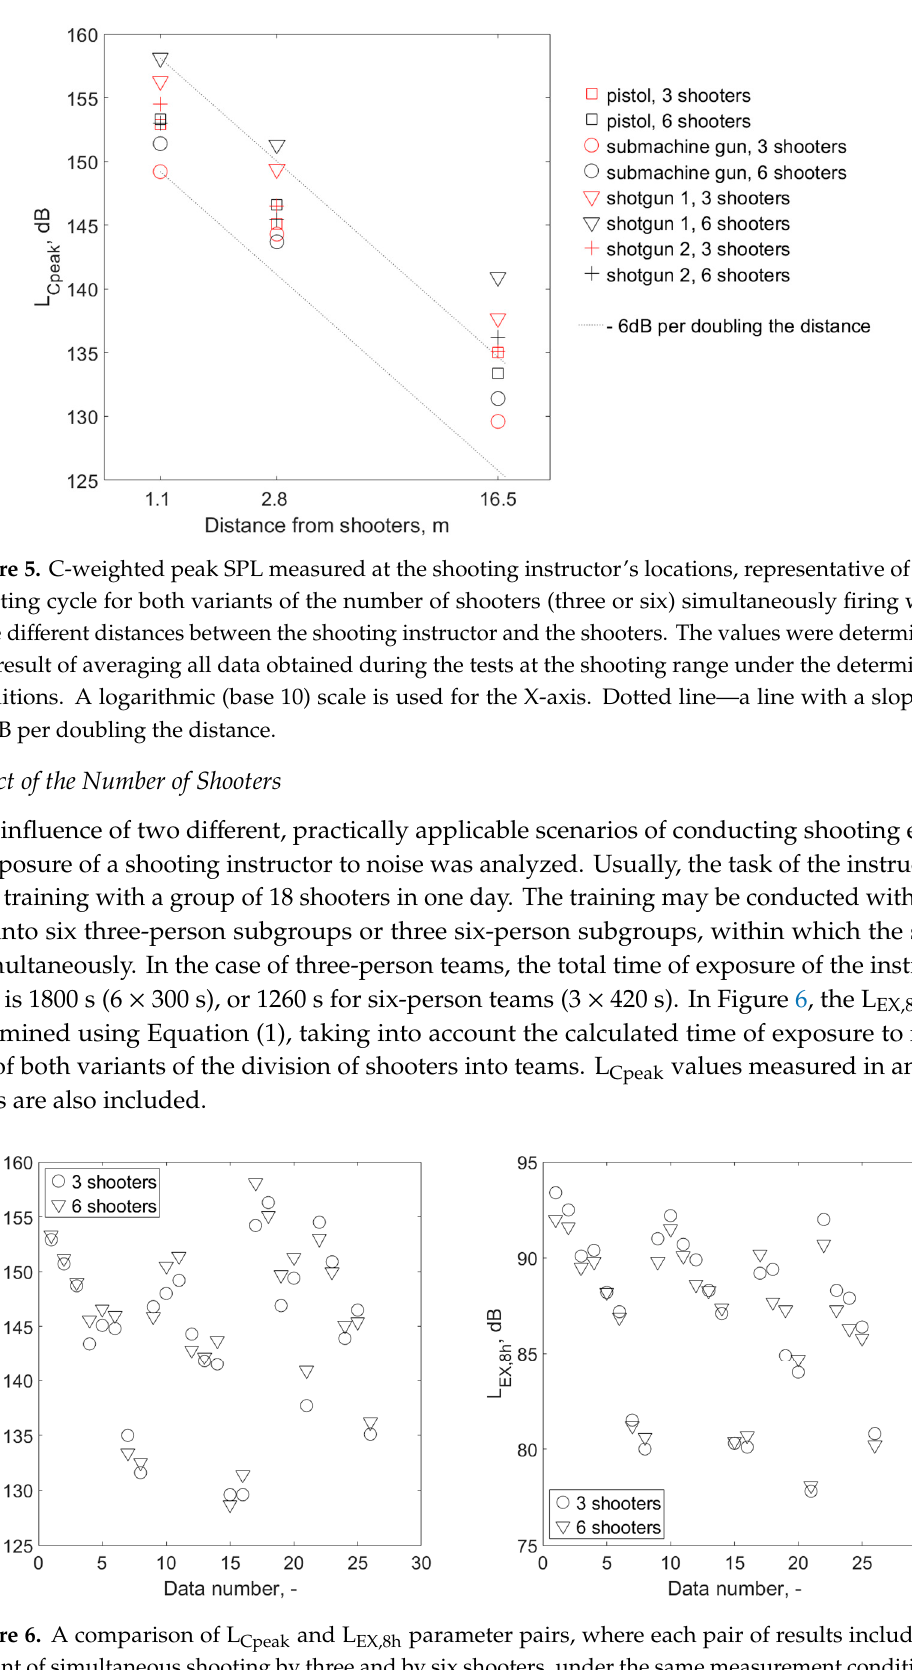
Figure 6. A comparison of L Cpeak and L EX,8h parameter pairs, where each pair of results includes a variant of simultaneous shooting by three and by six shooters, under the same measurement conditions, i.e., at a specified distance from shooters, using a specific weapon/ammunition